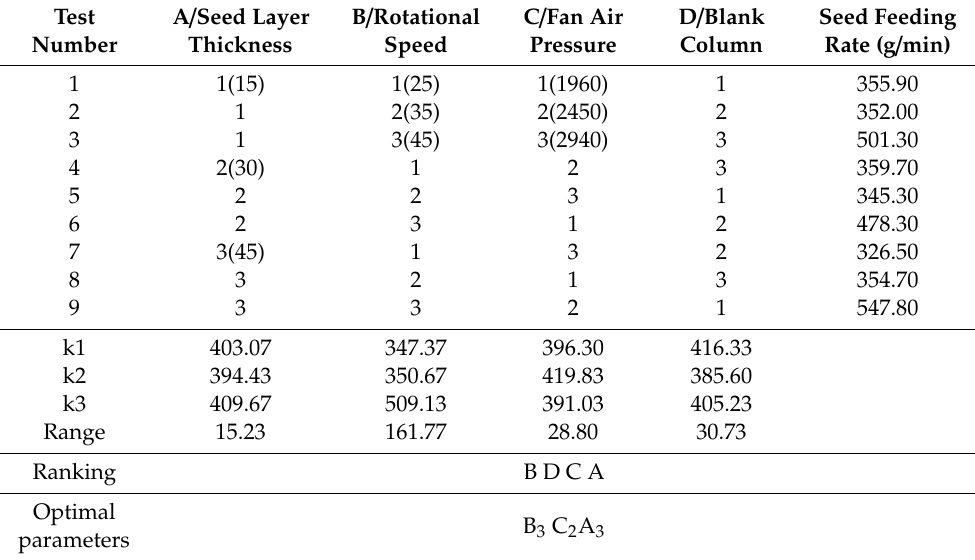
Table 2. Results of the standard orthogonal